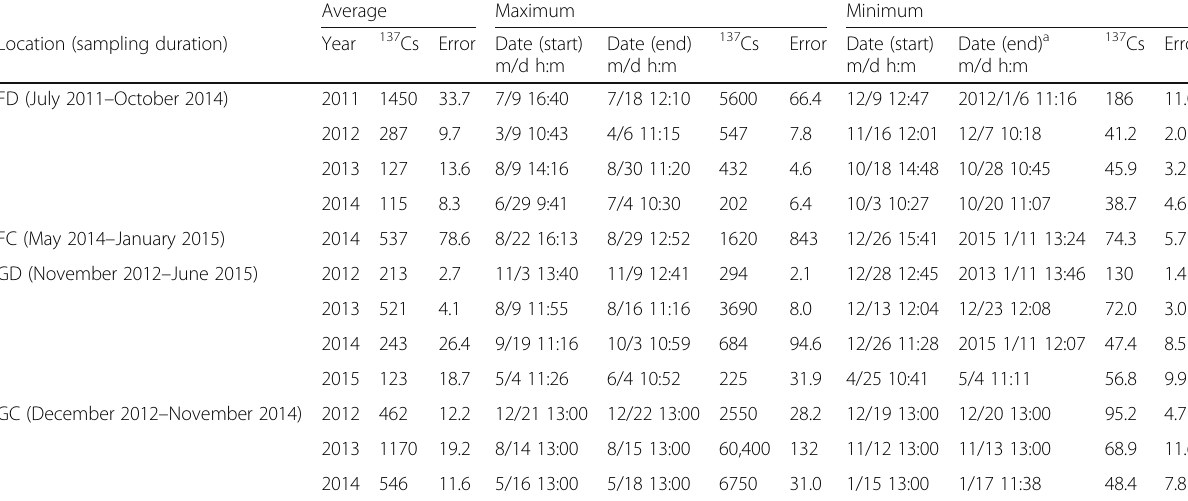
by impactor sampling as well as on the backup filter in the cascade impactor Table 3 Averages, maximums, and minimums of the 137 Cs activity concentration ( μ Bq m − 3 ) at each site Average Maximum Minimum Location (sampling